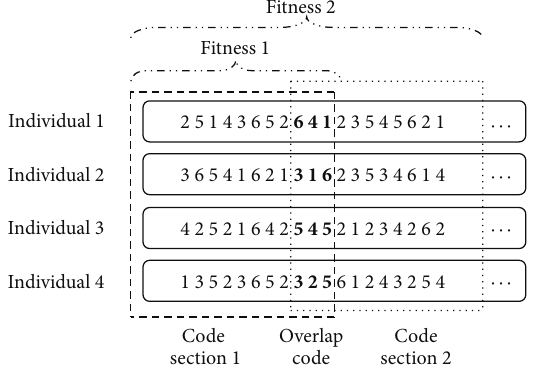
Figure 4: An optimization method combining subperiod rolling into